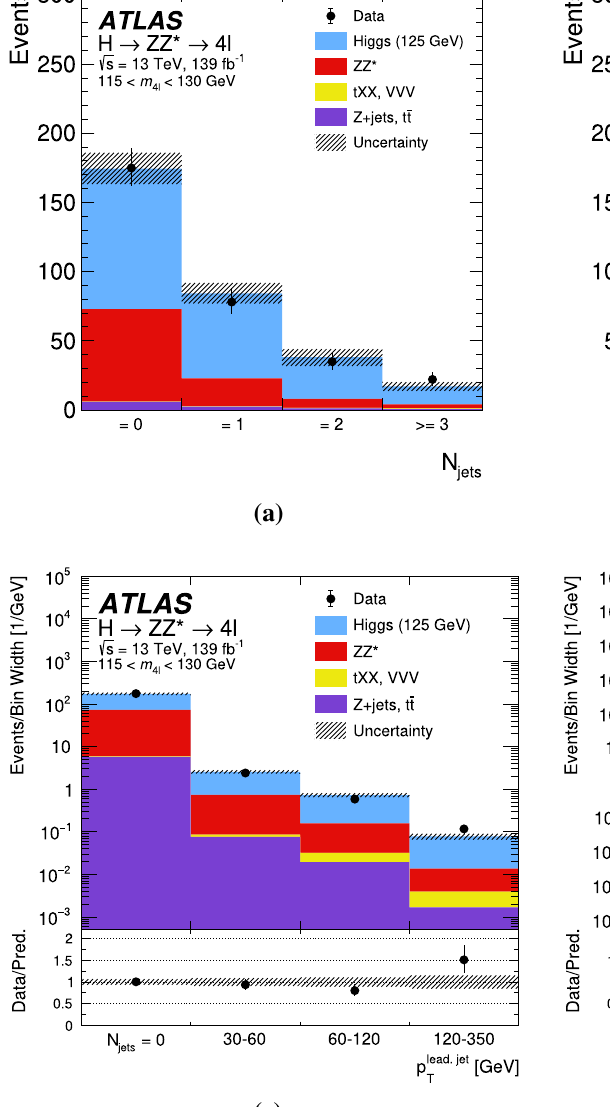
the signal and the Z Z ∗ background